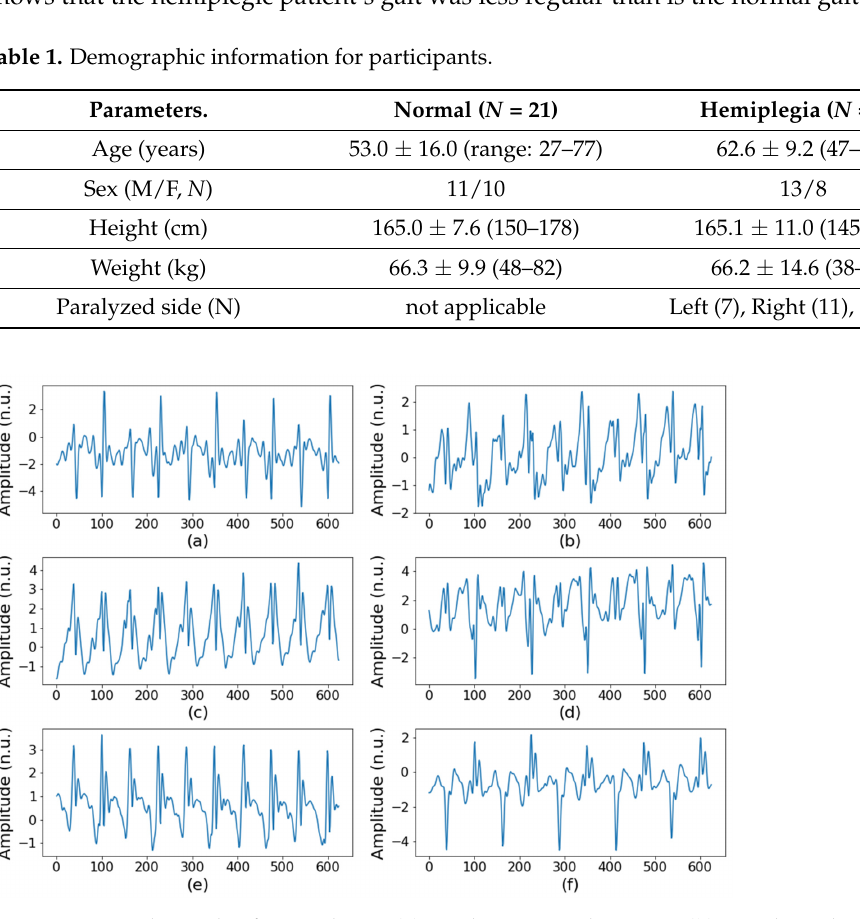
Figure 3. Inertial signals of hemiplegic gait: ( a ) acceleration in the x axis, ( b ) angular velocity in the x axis, ( c ) acceleration in the y axis, ( d ) angular velocity in the y axis, ( e ) acceleration in the z axis, and ( f ) angular velocity in the z axis.